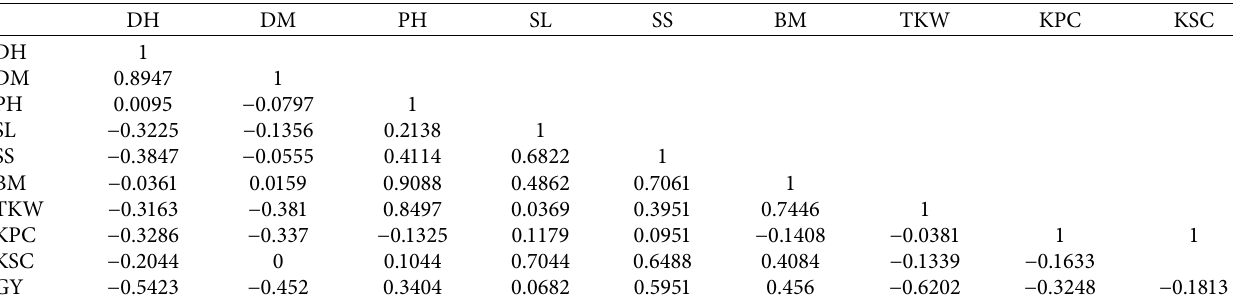
Table 4: Correlation of yield and other agronomic and quality